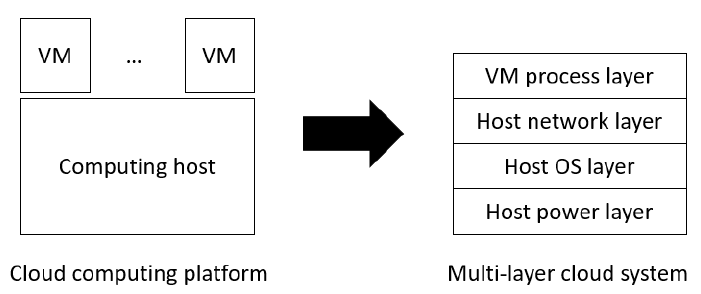
Figure 1. Schematic diagram of a multi-layer